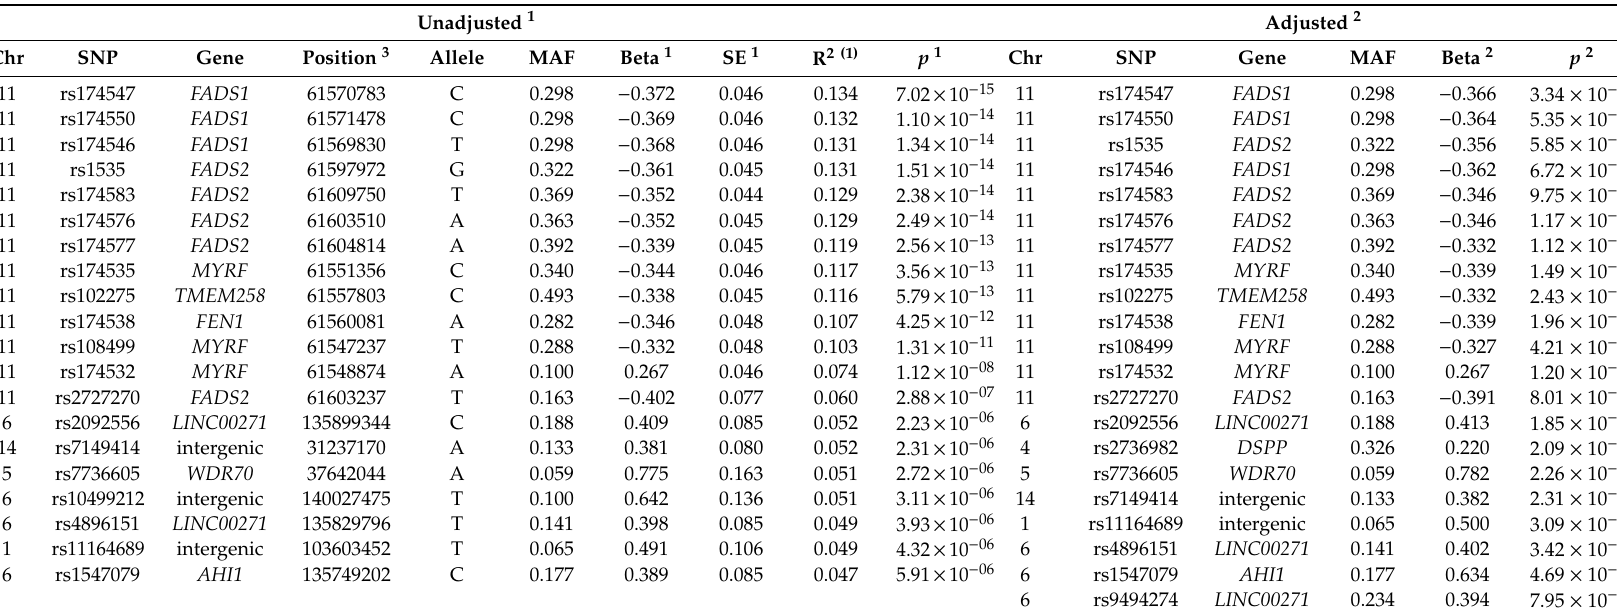
Table 2. Top-ranked single nucleotide polymorphisms (SNPs) in the genome-wide association study (GWAS) for serum omega-3 fatty acid concentrations (%) in the whole